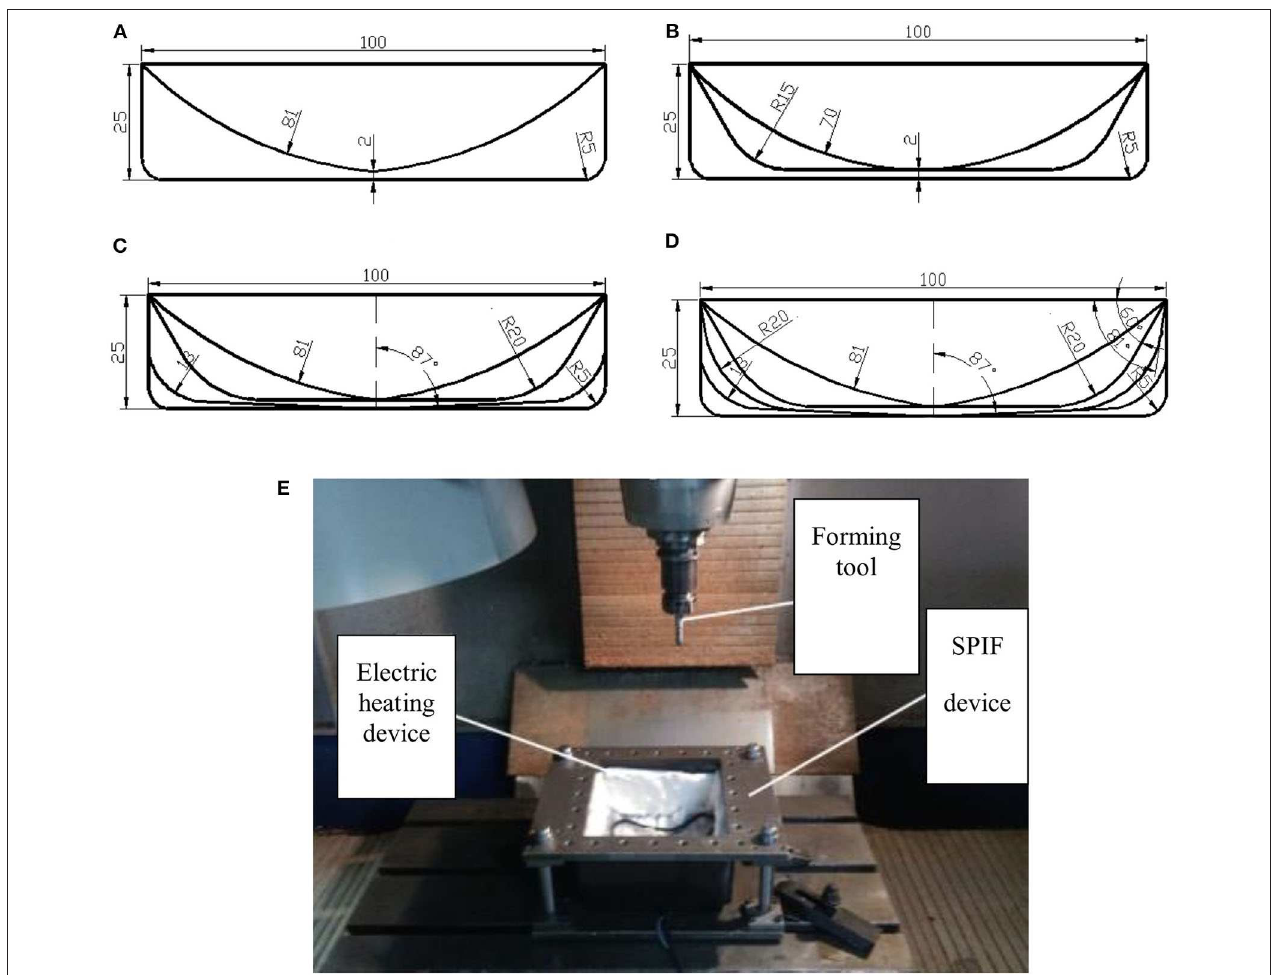
FIGURE 4 | Schematic diagram of forming trajectory for different multistage forming and experiment equipment: (A) two-stage forming; (B) three-stage forming; (C) four-stage forming; (D) five-stage forming; (E) the experiment equipment of SPIF.